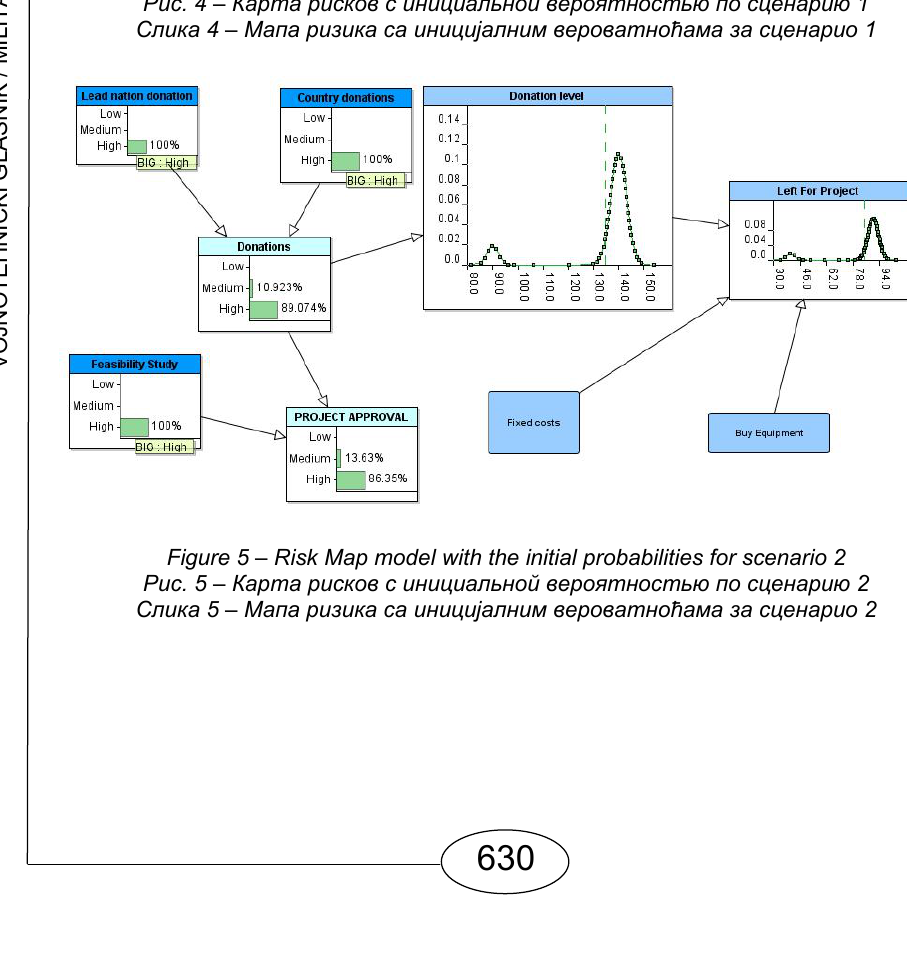
Figure 4 – Risk Map model with the initial probabilities for scenario 1 Рис . 4 – Карта рисков с инициальной вероятностью по сценарию 1